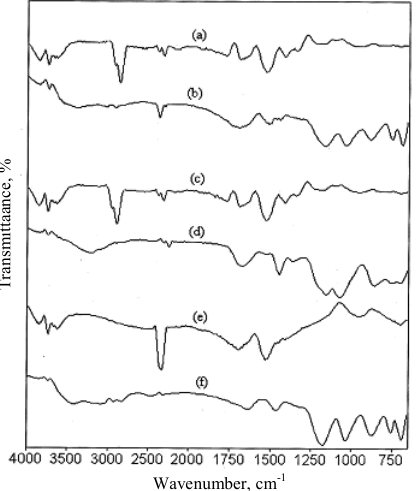
Figure 1. (a) PS (b) S-PS (c) PAN (d) S-PAN (e) SAN (f) S-SAN.